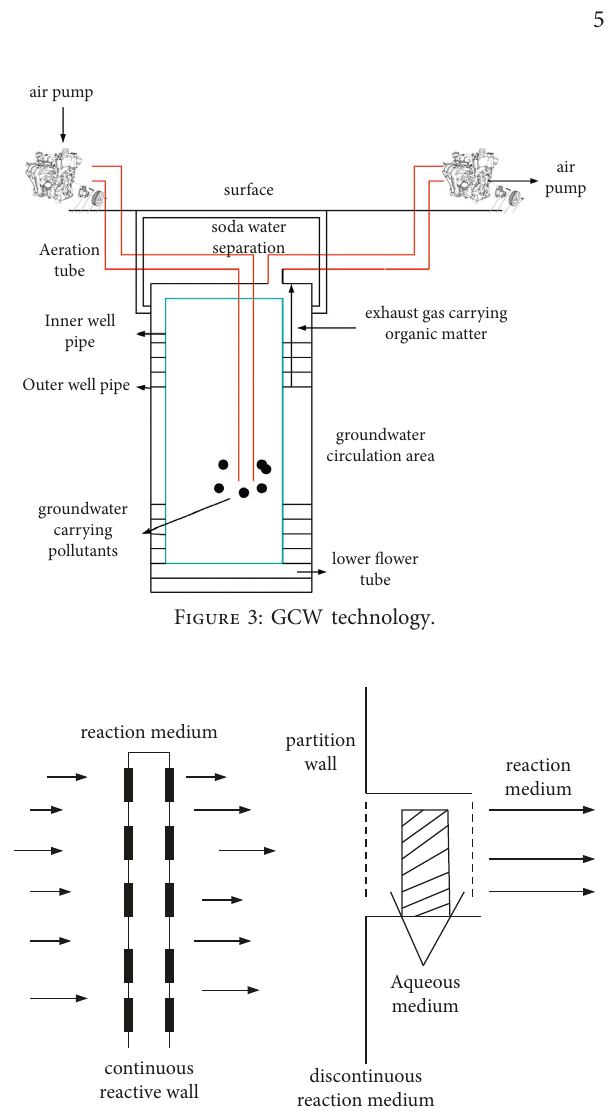
Figure 4: The process of oxygen species